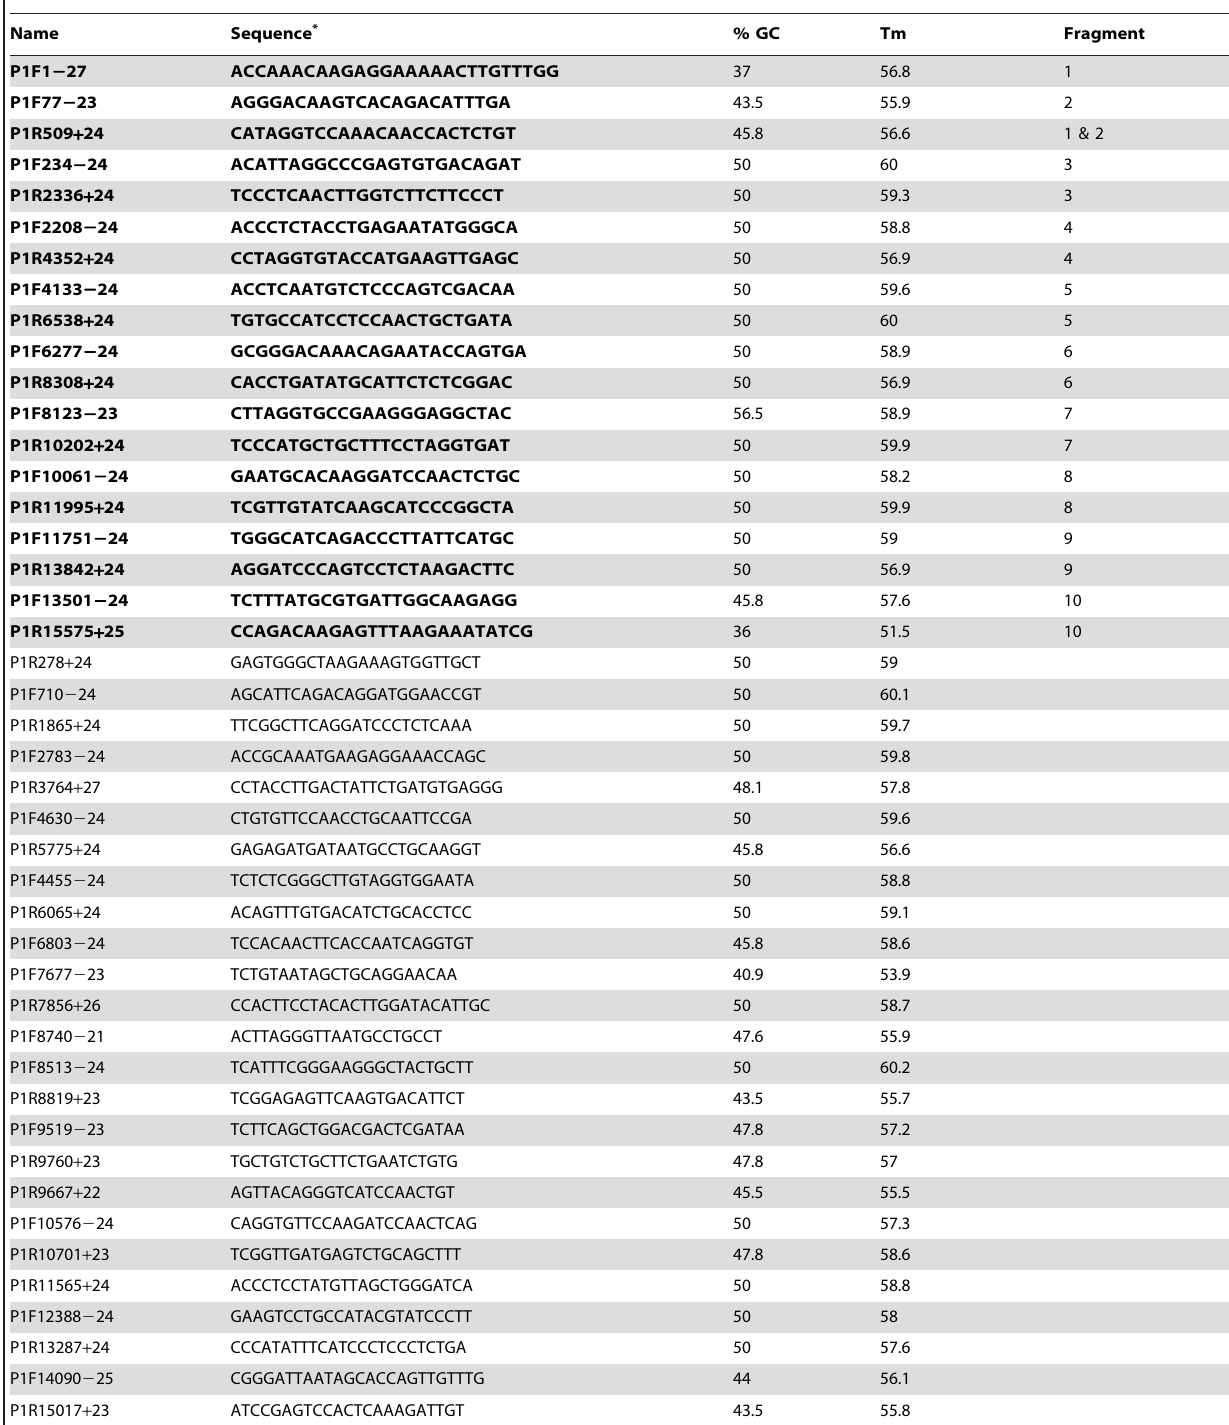
*Bold font represents oligonucleotides used for amplification. All primers were used for sequencing. The primer names are designed as follows: 1) The ‘‘P1’’ at the beginning indicates that these are HPIV-1 primers, 2) The ‘‘F’’ or ‘‘R’’ located at the third position of the primer name indicates whether the primer is in the forward or reverse orientation, 3) the number between the ‘‘F’’ or ‘‘R’’ and the hyphen corresponds to the nucleotide position of the 5 9 end of the oligonucleotide in the HPIV-1 genome, and 4) adding or subtracting the number at the end of the primer name from the nucleotide position of the 5 9 end of the oligonucleotide is the nucleotide position of the 3 9 end of the oligonucleotide.